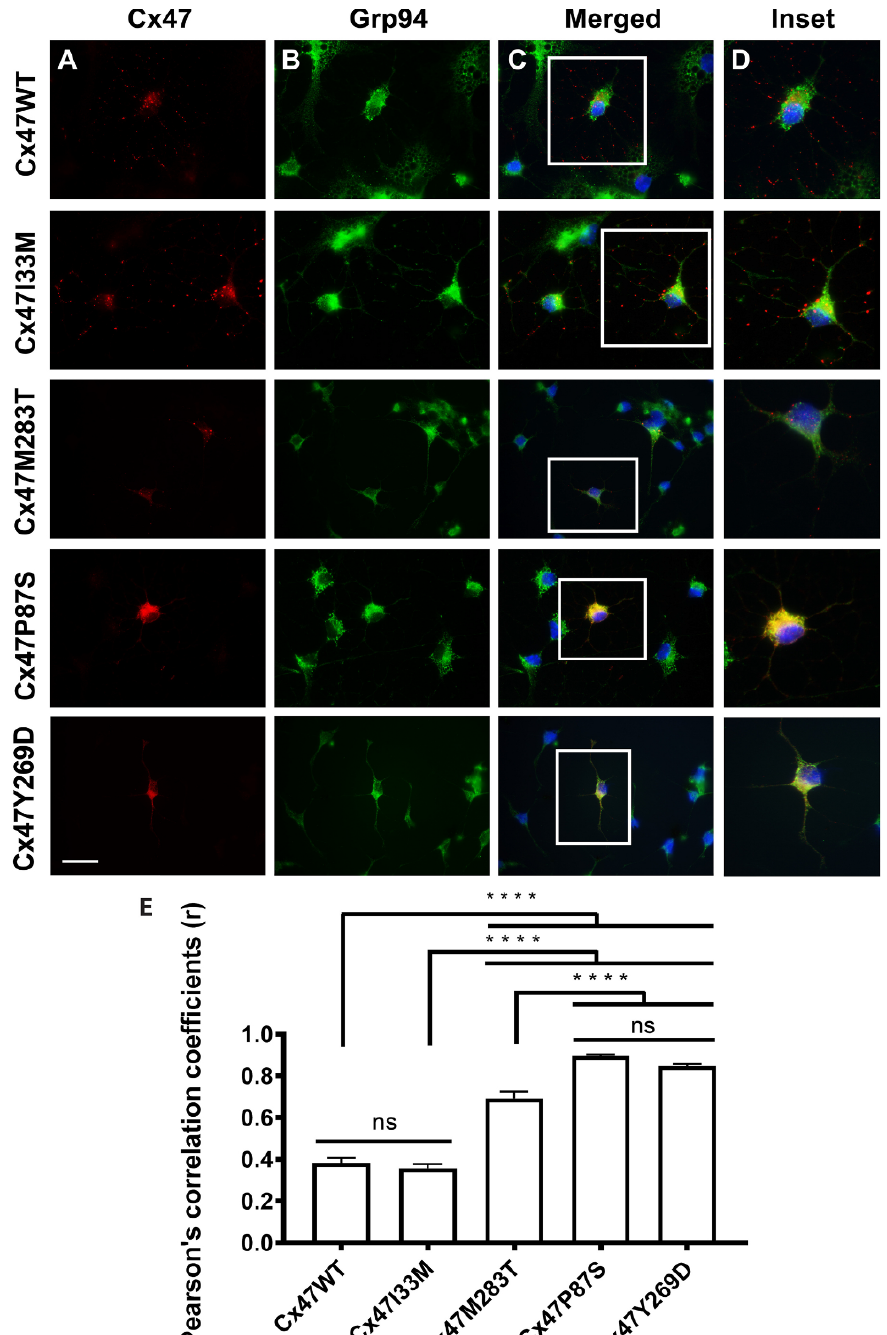
Figure 4. Expression of Cx47WT and mutants in primary OLs. ( A ) Cx47 staining (red) for Cx47WT and p.I33M show a punctate staining pattern while PMLD associated mutations show diffuse cyto ‐ plasmic staining (p.P87S, p.Y269D) or both punctate and diffuse staining (p.M283T). Empty vector control showed no Cx47 staining. ( B ) Staining for GRP94 (green), a marker of the ER compartment. ( C ) Staining for Cx47 (red), GRP94 (green) and DAPI (blue) shows colocalization of p.P87S and p.Y269D and slightly reduced colocalization of GRP94 with p.M283T. Scale bar = 25 μ m. ( D ) Insets of indicated areas in C. ( E ) Quantitation of colocalization with Pearson’s correlation coefficient. ANOVA p < 0.05, Tukey post ‐ hoc test, **** p < 0.0001, ns = not statistically significant. Figure and legend from Flores ‐ Obando 2022 [153] used with permission of Elsevier. Copyright © 2023.